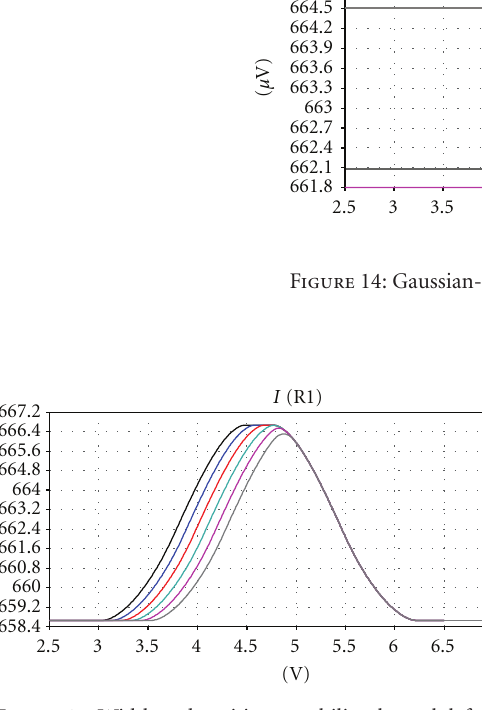
Figure 15: Width and position tunability through left side.